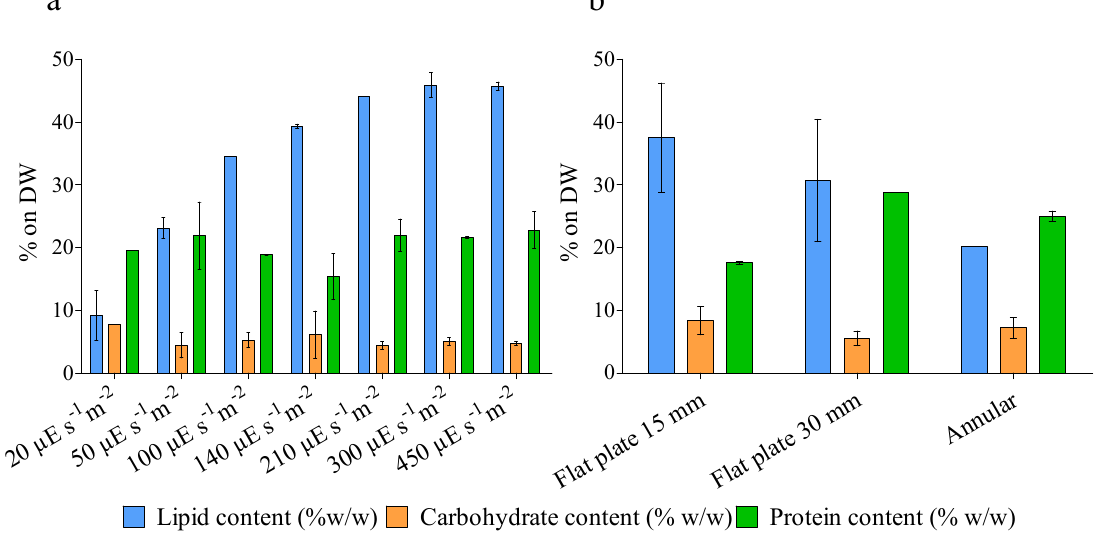
Figure 8. Biochemical composition of the biomass obtained at the end of the batch cultivations grown under different conditions: ( a ) quasi-isoactinic reactor with different photon flux densities; ( b ) reactors with different configurations at incident light intensity I 0 = 210 µE s − 1 m − 2 .